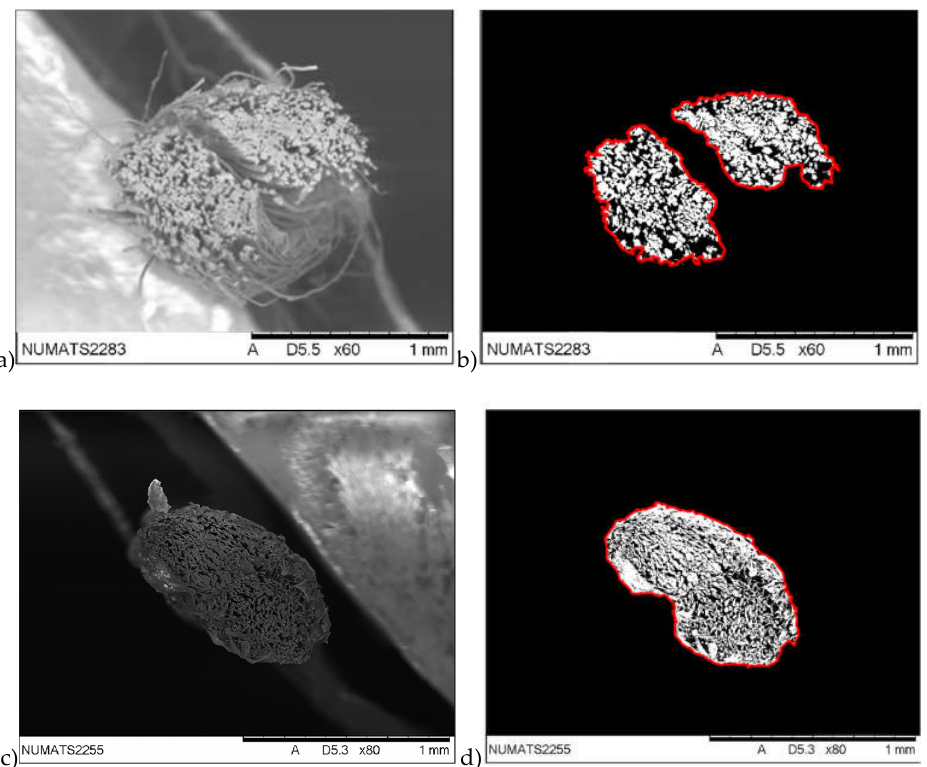
Figure 3. Yarns’ morphology identification: ( a ) non-impregnated yarn scanning electron microscope (SEM) image; ( b ) non-impregnated yarn manipulated SEM image; ( c ) impregnated yarn SEM image; ( d ) impregnated yarn manipulated SEM image.